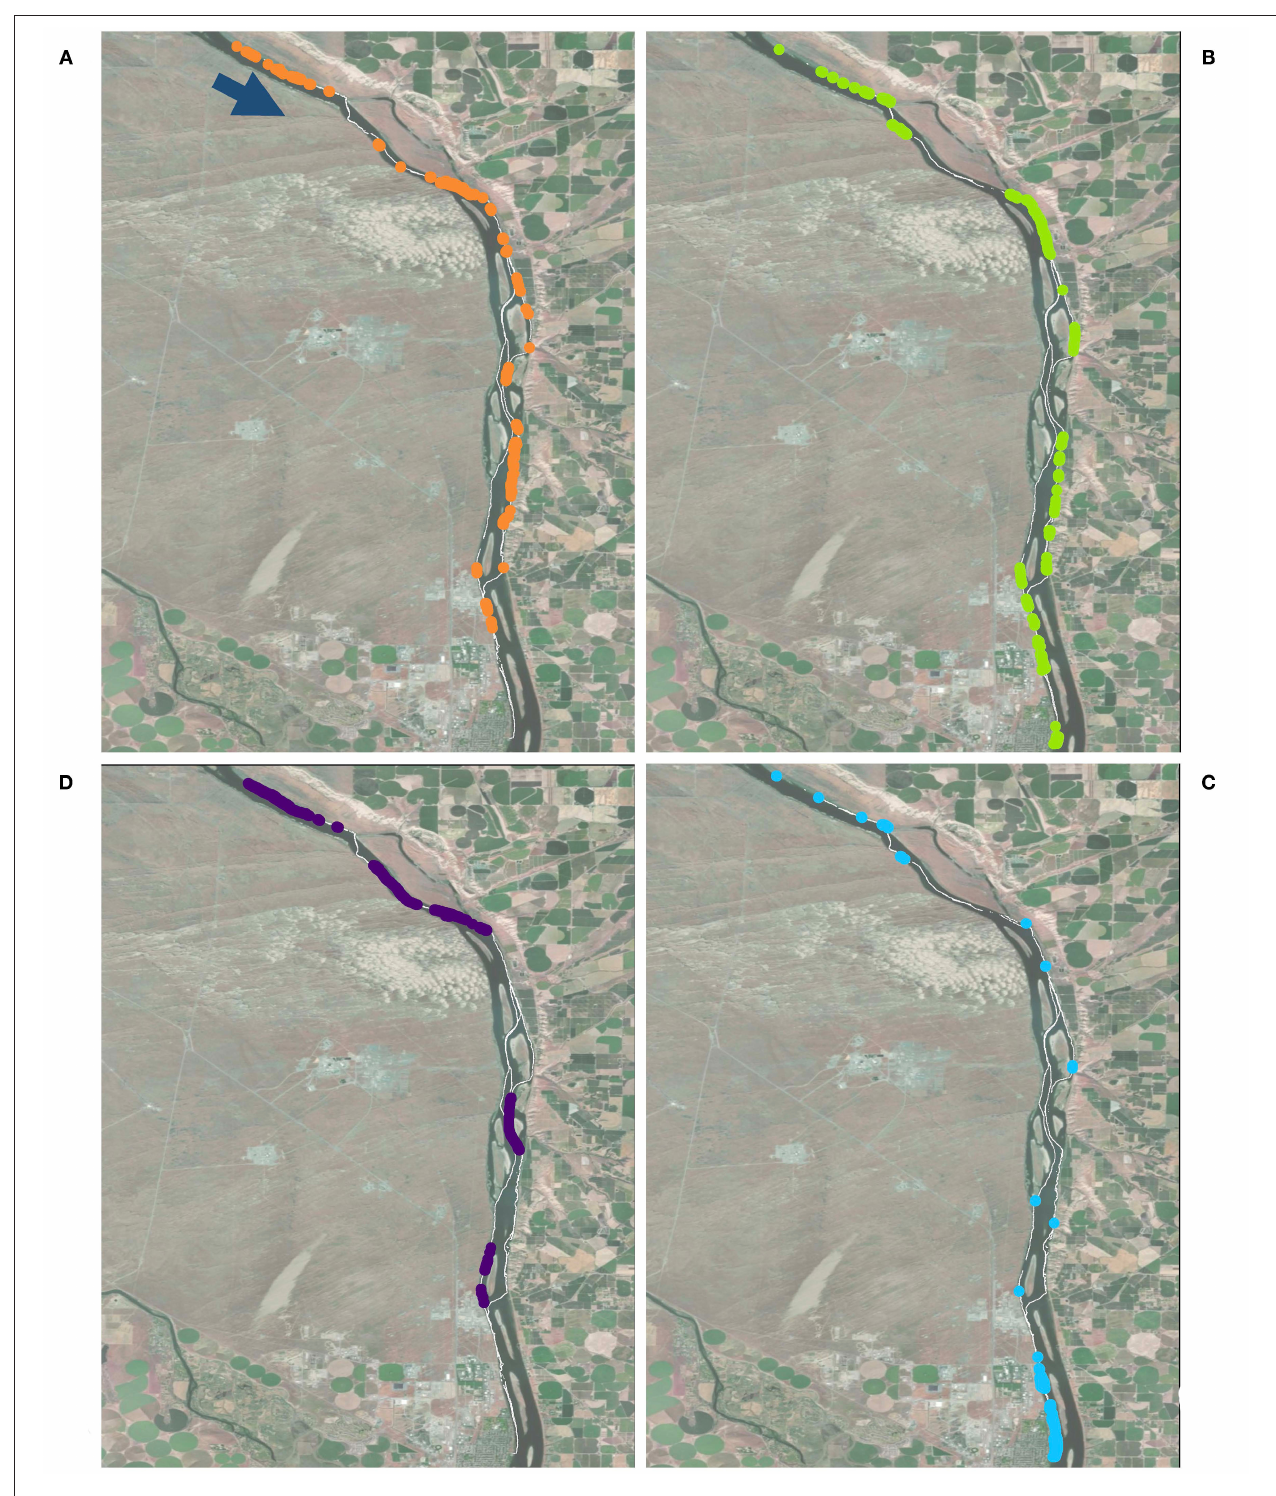
FIGURE 10 | Anomalies observed from August 1–14 that were (A) Category 1 (high EC; low temperature), (B) Category 2 (high EC; high temperature), (C) Category 3 (not anomalous EC; high temperature), and (D) Category 4 (not anomalous EC; low temperature) are all present during this time range, but each category of anomaly is only present in a few locations. Category 3 anomalies are clustered near the southern end of the study site, and Category 4 anomalies are clustered near the northern end of the study site. The white line shows all the paths traversed during this time period. Map data from Google, Landsat.